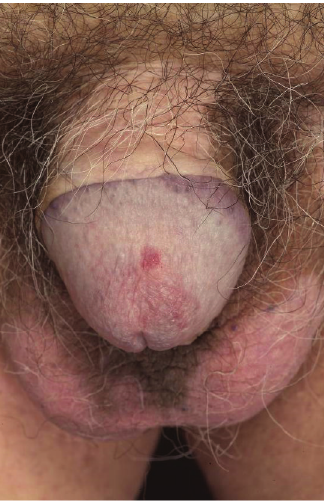
Figure 2: Scrotal and penile vitiligo with a region of lichen planus lesion on the glans.